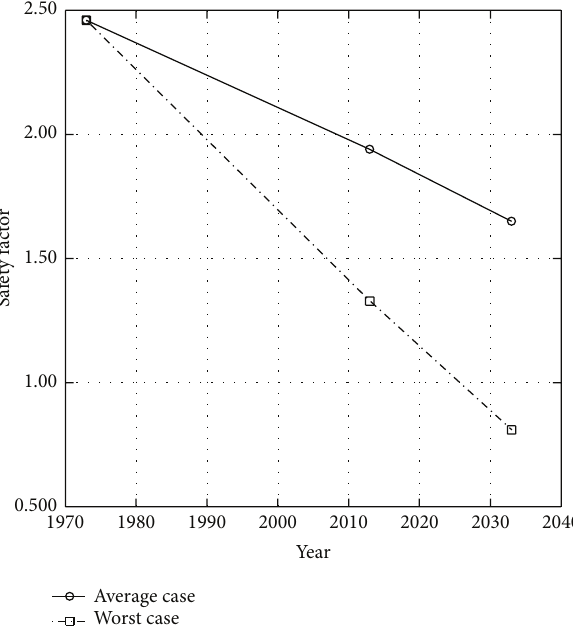
Figure 27: Safety factor for beam element with 500 mm × 800 mm cross-section reinforced with 4D28 mm diameter rebar against